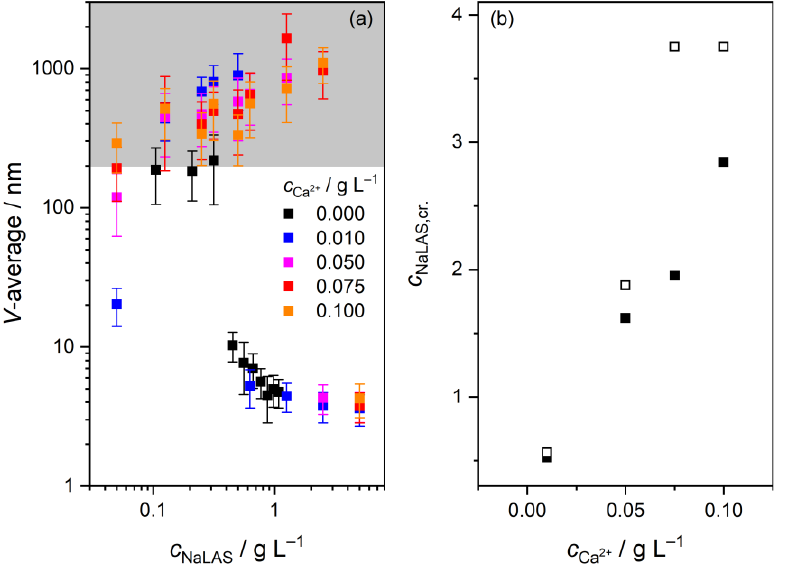
Figure 3. ( a ) Volume-averaged particle diameter as a function of sodium linear alkylbenzene sulfonate (NaLAS) concentration, in the presence of CaCl 2 . The error bars correspond to the highest error of the fit obtained within at least three measurements for each sample. The gray-colored region refers to samples found opaque by visual inspection; ( b ) Apparent second ‘critical’ surfactant concentration ( c NaLAS,cr. ) as a function of Ca 2+ -ion concentration, as estimated from surface tension (full squares) and dynamic light scattering (empty squares) measurements. Experimental conditions: c Ca2+ = 0 – 0.1 g L – 1 , c NaLAS = 0.001 – 5.00 g L – 1 , T = (25 ± 0.1) °C.